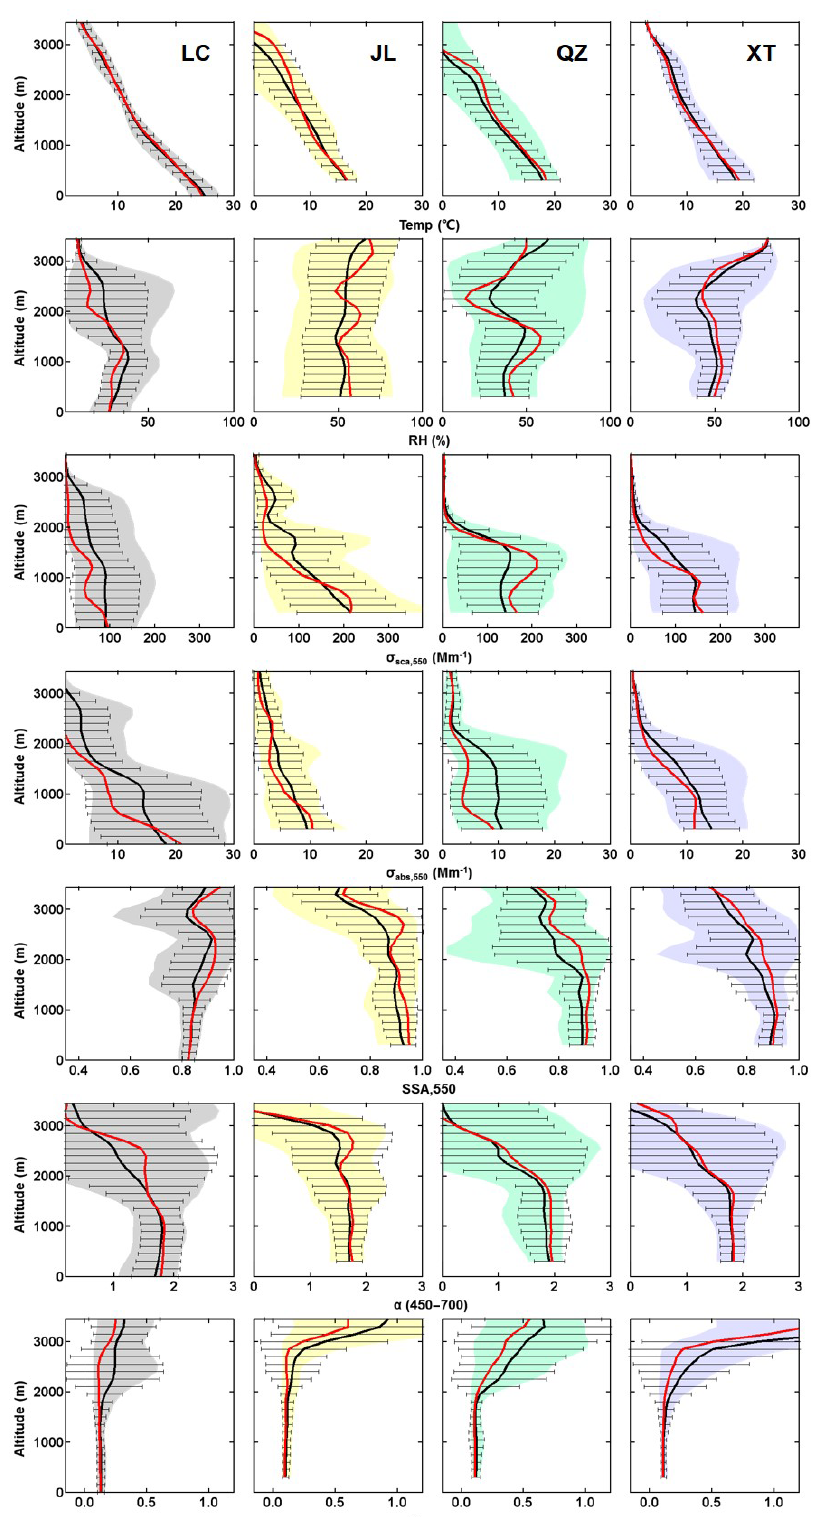
Figure 4. Mean vertical distributions of (from the top row to the bottom row) temperature ( ◦ C), relative humidity (%), σ sca at 550nm (Mm − 1 ), σ abs at 550nm (Mm − 1 ), SSA at 550nm, Ångström exponent ( α ), and β sca at 550nm over LC, JL, QZ, and XT (from the left column to the right column, respectively). Black and red lines represent the mean and the median, respectively, and horizontal bars are standard deviations at every 150m level. The colored shaded areas represent the 10th and 90th percentiles of the